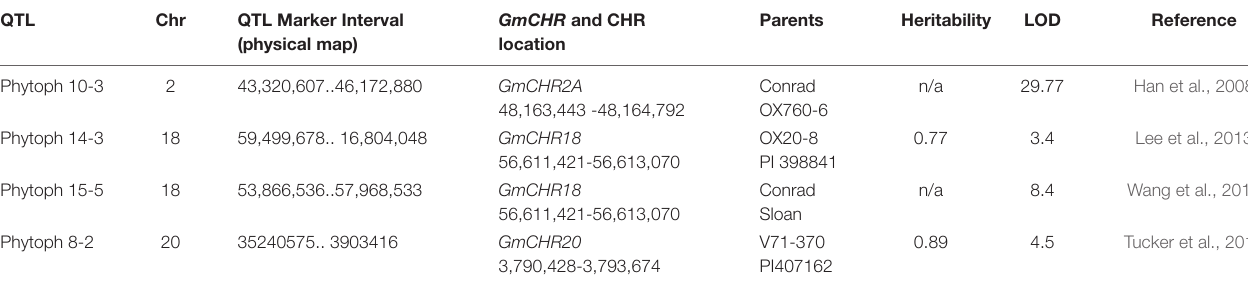
TABLE 3 | Characteristics of QTLs linked to P. sojae resistance that contain